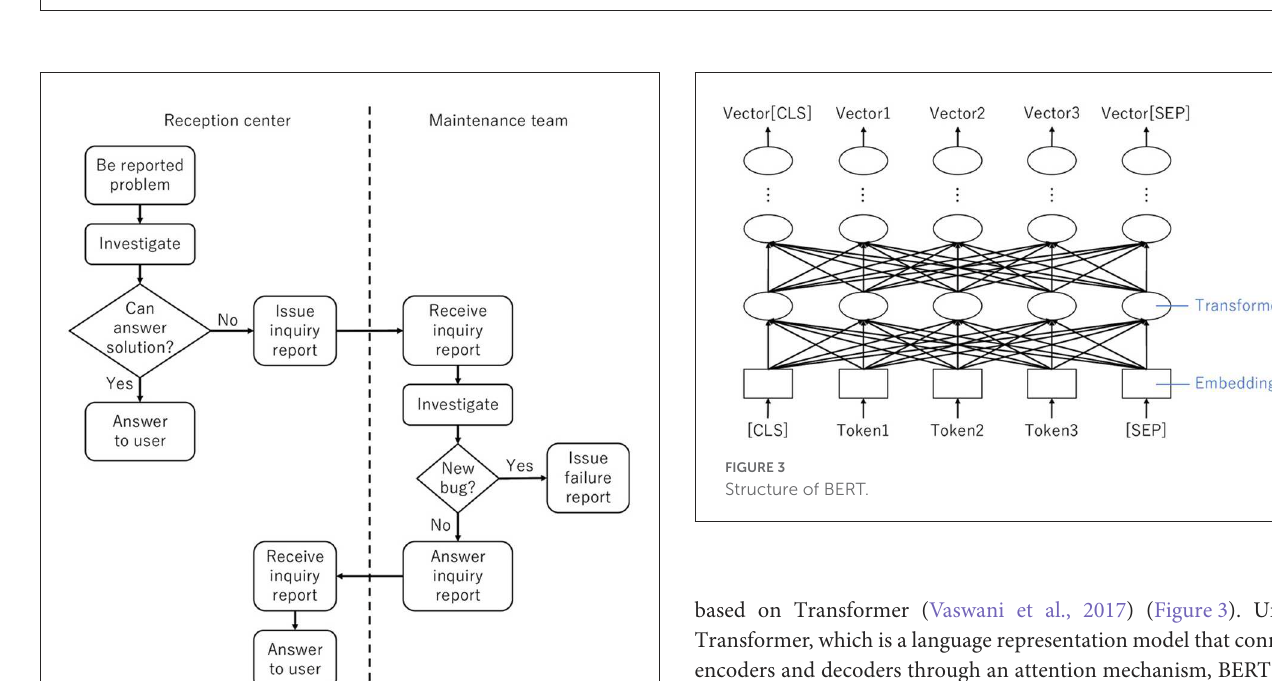
FIGURE1 Overview of the maintenance process.